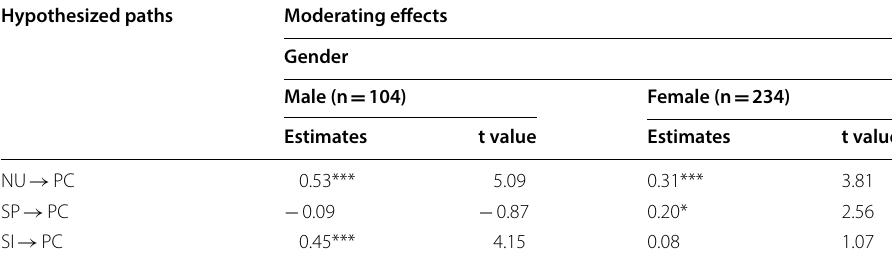
NU need for uniqueness; SP self-promotion; SI social identity; PC perception of customization *** p < 0.001, * p <